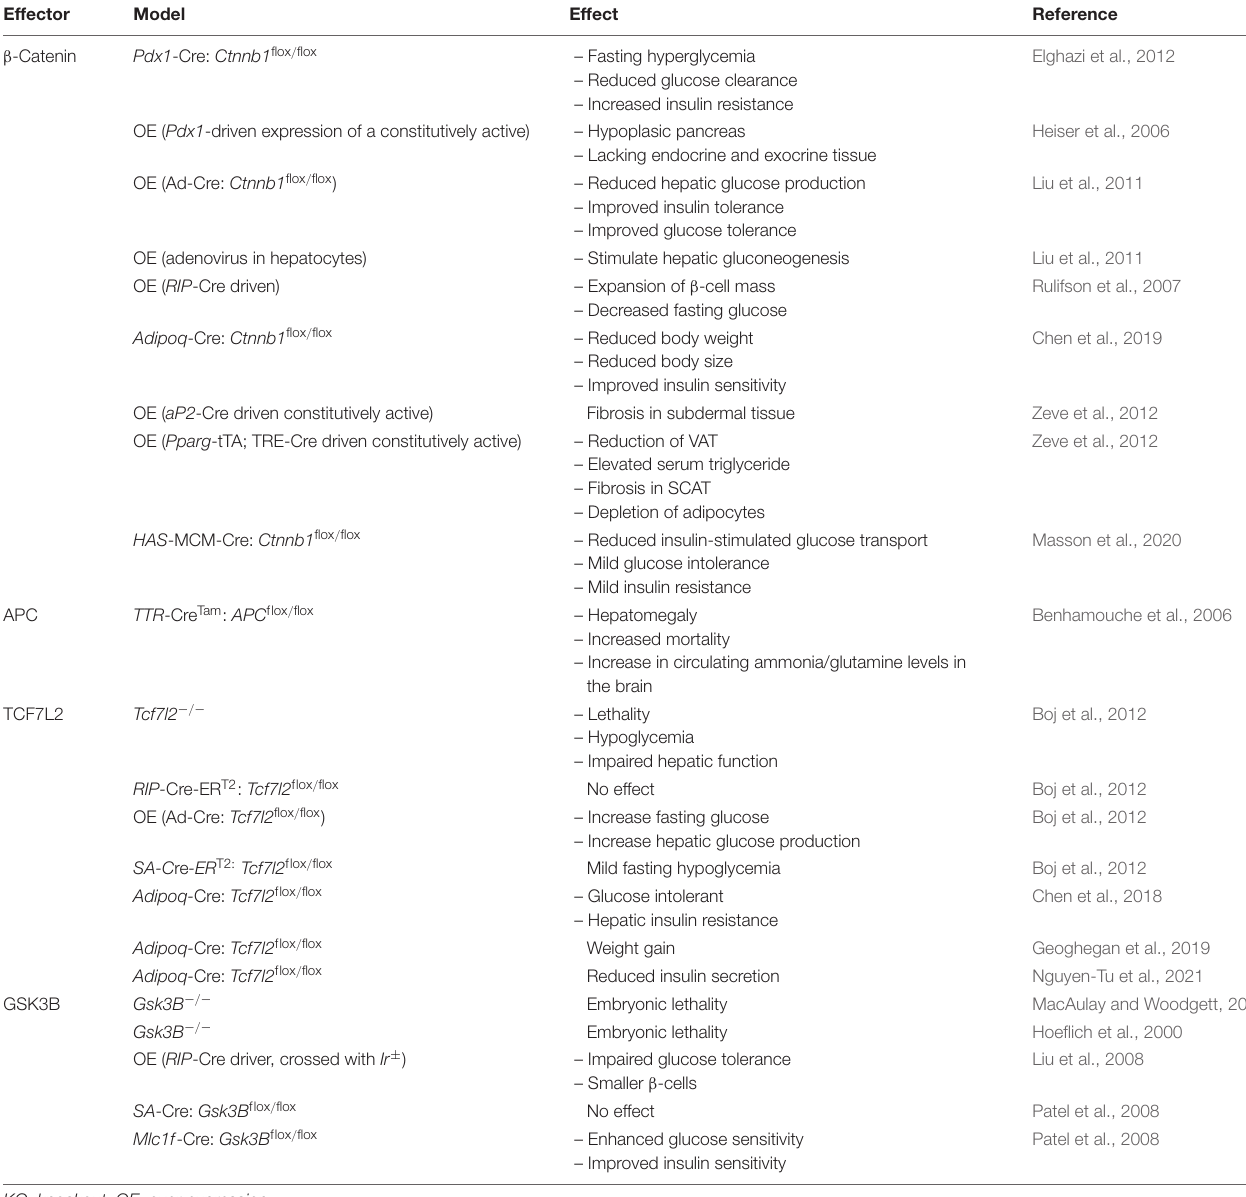
TABLE 4 | Metabolic phenotype resulting from the over-expression or deletion of Wnt signaling effectors in mice.